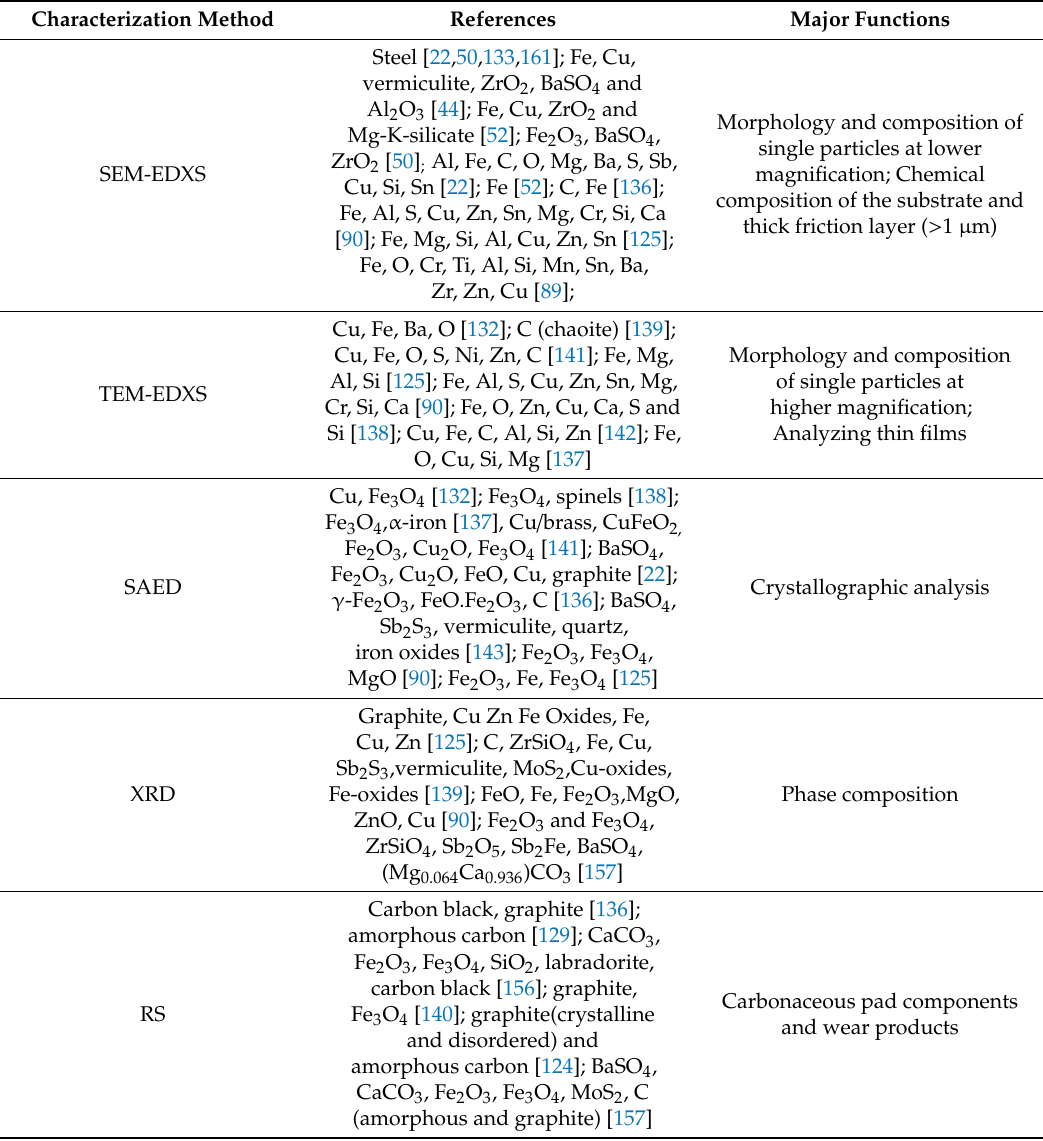
Table 7. Overview of di ff erent characterization tools used for wear debris and friction layer